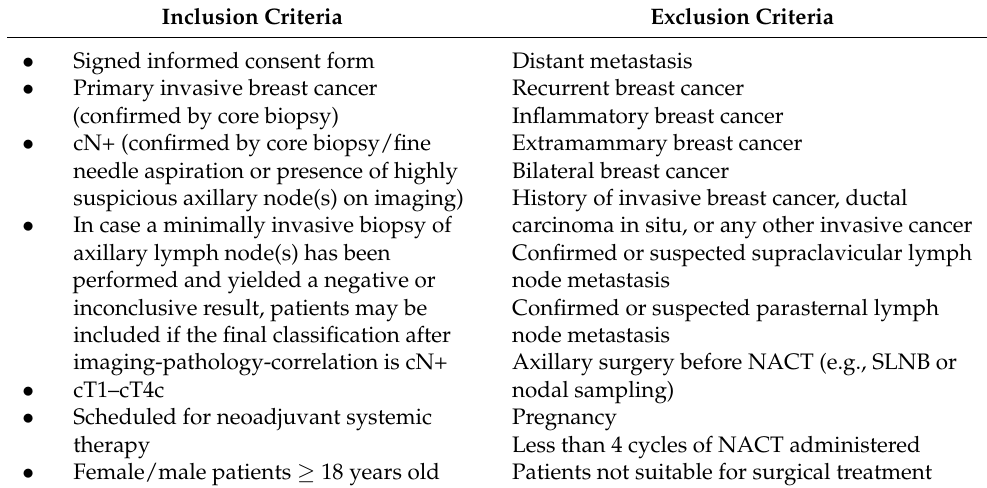
Table 8. The AXSANA study: Inclusion and exclusion criteria. Inclusion Criteria Exclusion